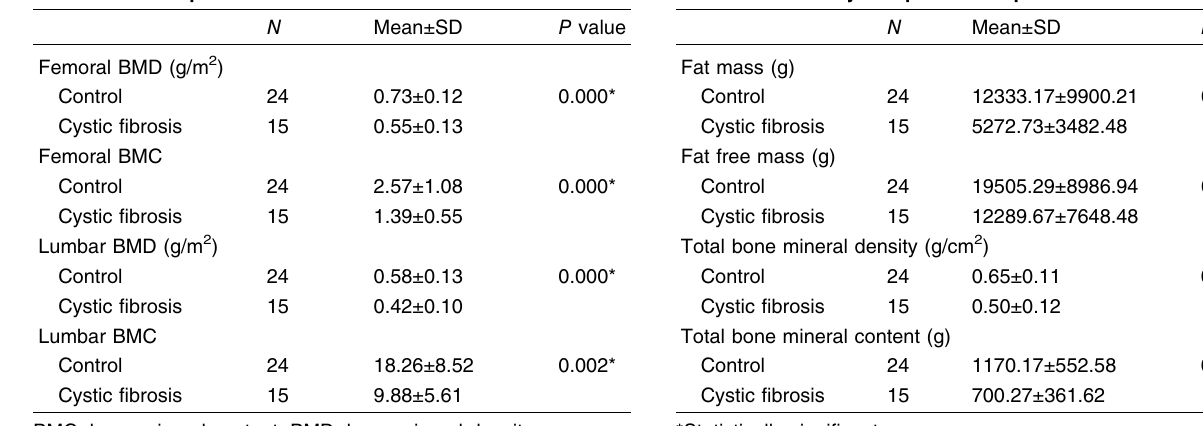
Table 3 BMD in patients and controls Table 4 Total body composition in patients and